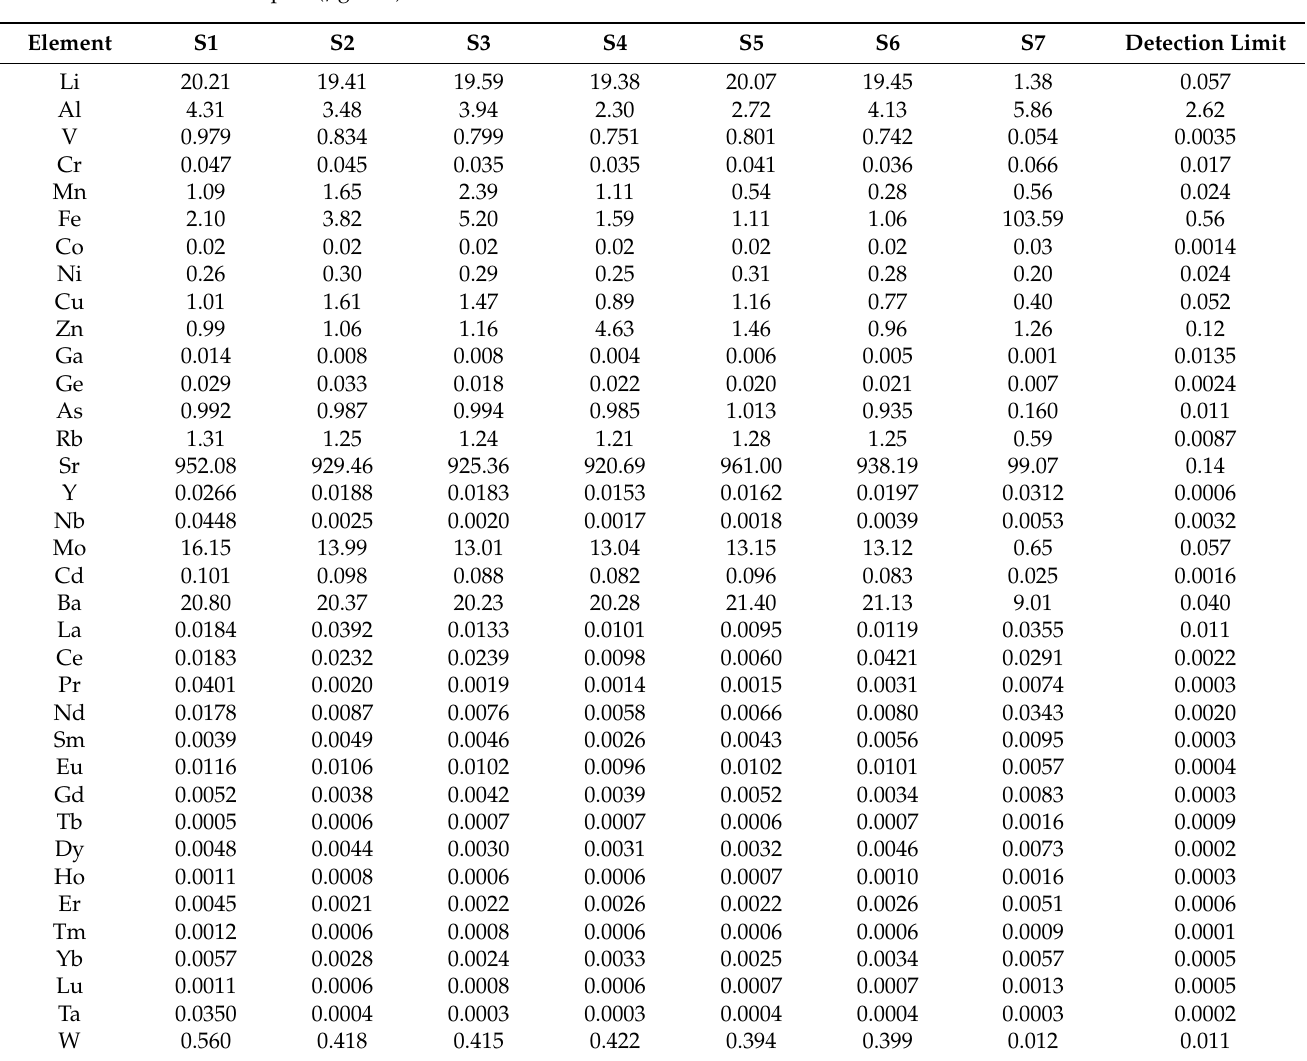
Table 5. The mean value of the trace element concentrations of the Gusinoe Lake in July–August during 2016–2018; n = 9—number of samples ( µ g · L − 1